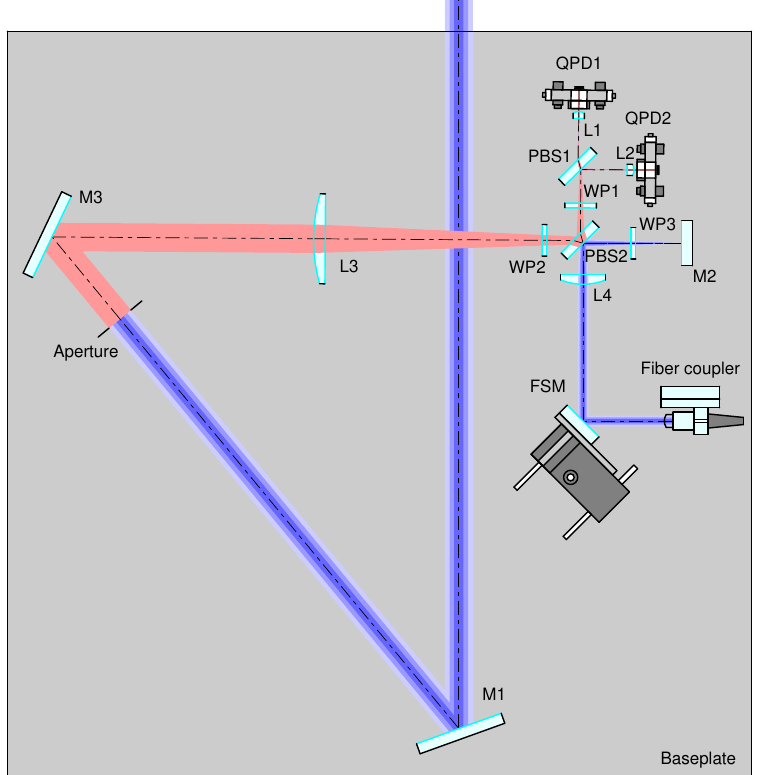
Figure 4. LRI OB as modeled in IFOCAD and drawn in OPTOCAD. The RX beams starts at the receive aperture (red). The TX and LO beams stem from the beam injected into the OB by the fiber injector (blue). The baseplate assumed in the thermal analysis is drawn as a rectangle enclosing all of the OB